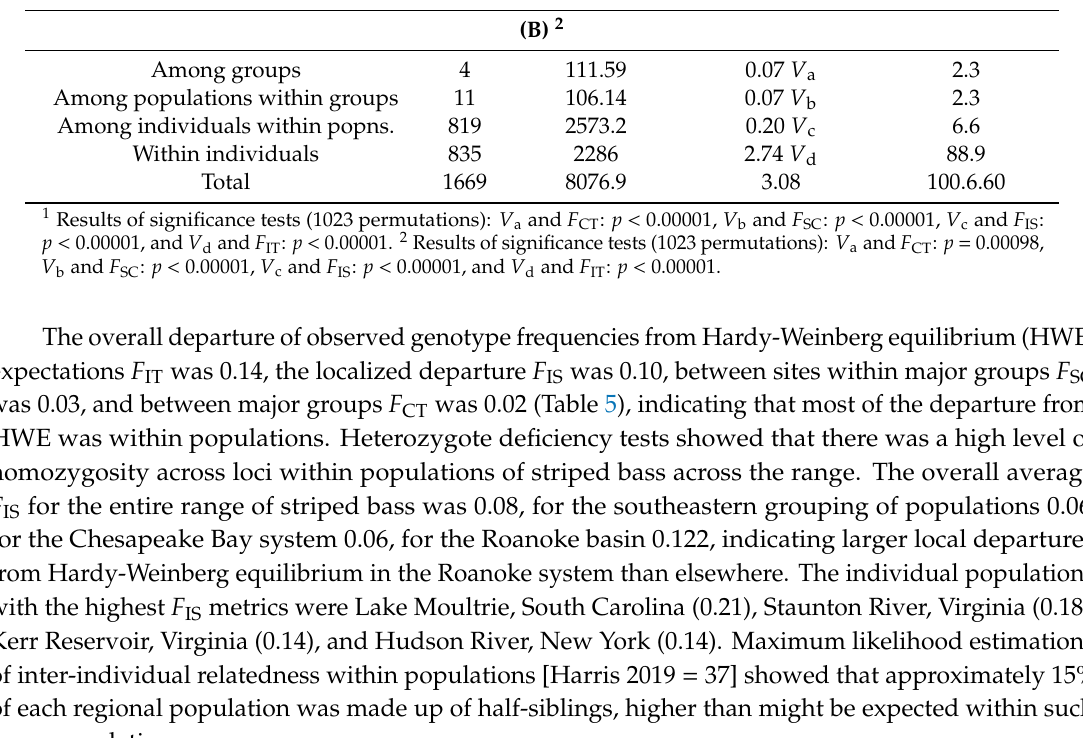
Table 4. AMOVA results for collections across the range of striped bass. (A) For four groups: Southeast, Roanoke basin, Chesapeake Bay, and Hudson River; (B) for five groups: Santee-Cooper system, Cape Fear / Neuse / Tar rivers, Roanoke basin, Chesapeake Bay, and Hudson River. Percentage of Sum of Variance Source of Variation d.f. Variation Squares Components 1 (A) 1 Among groups 3 149.77 0.08 V a 2.1 Among populations within groups 12 169.96 0.11 V b 2.8 Among individuals within popns. 821 3536.83 0.39 V c 9.5 Within individuals 837 2951 3.53 V d 85.7 Total 1673 6807.56 4.09 100 (B) 2 Among groups 4 111.59 0.07 V a 2.3 Among populations within groups 11 106.14 0.07 V b 2.3 Among individuals within popns. 819 2573.2 0.20 V c 6.6 Within individuals 835 2286 2.74 V d 88.9 Total 1669 8076.9 3.08 100.6.60